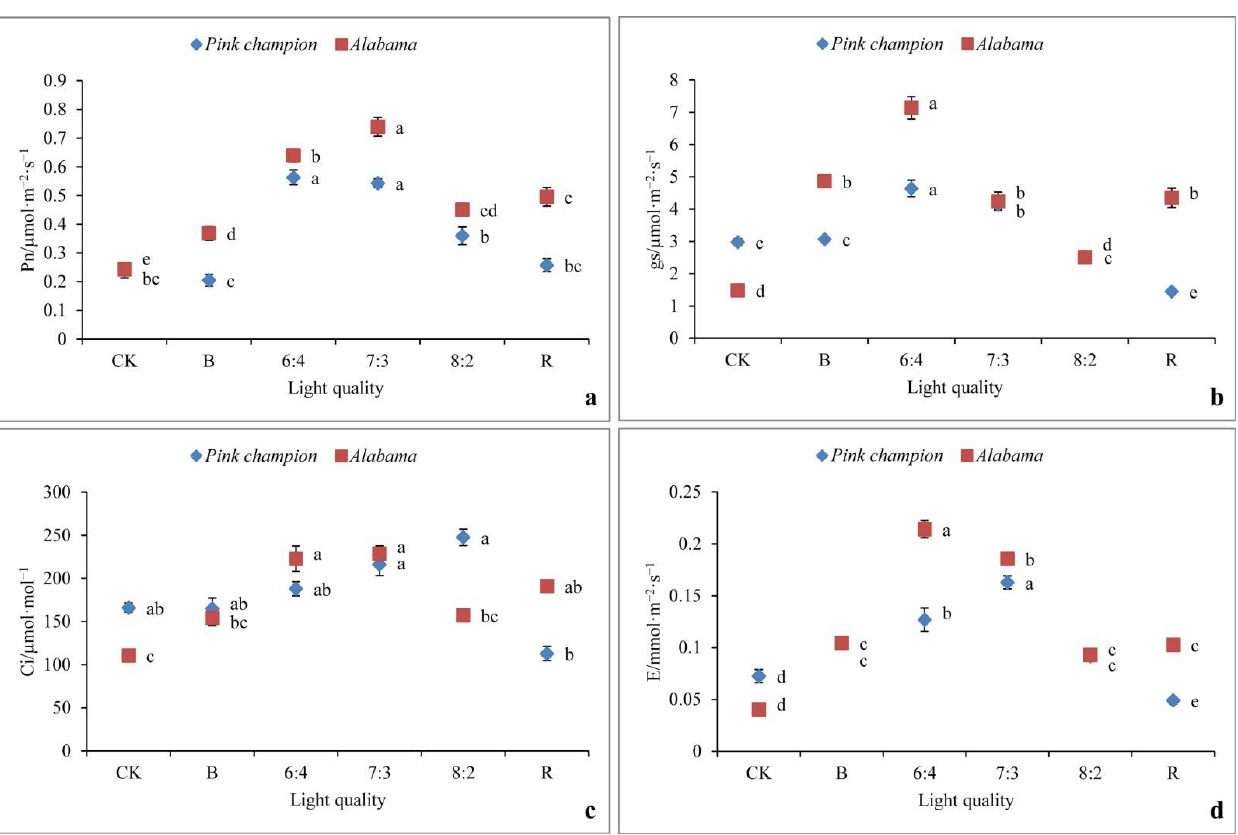
Figure 5. Effects of different light qualities on photosynthetic parameters of Anthurium ‘Pink Champion, Alabama’ (( a ) Pn, ( b ) gs, ( c ) Ci, ( d ) E.). The statistical analysis has been carried out separately for each cultivar. Vertical bars indicate standard error ( n = 5). Different letters represent a significant difference at p < 0.05 among treatments by the Duncan’s multiple range test.